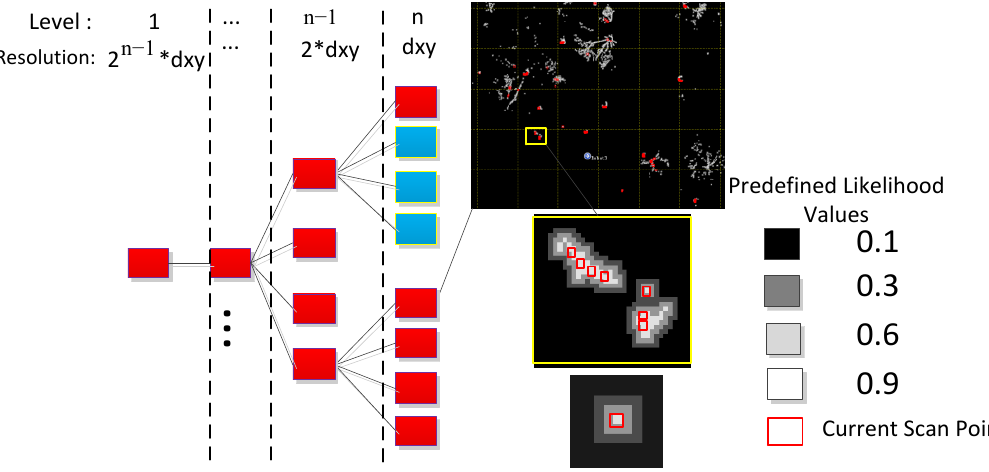
Figure 4. The pyramid structure of the likelihood map and LiDAR scan-matching example of the